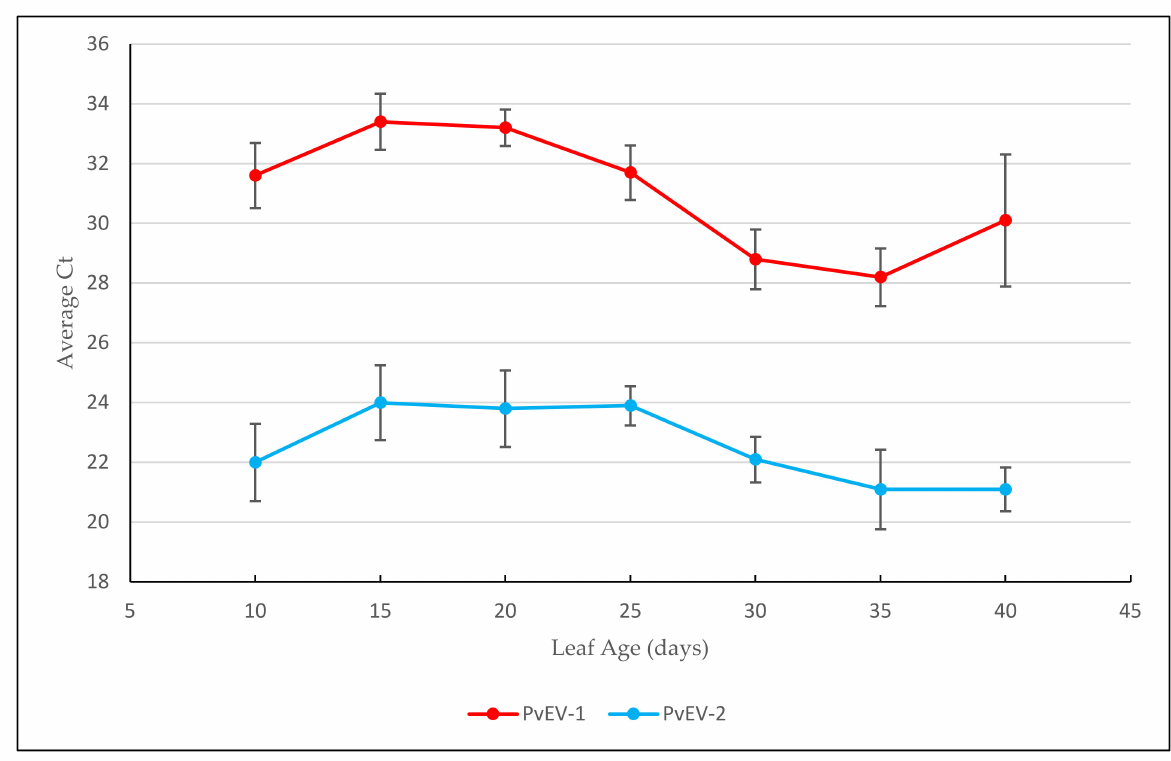
Figure 1. Average Ct values of endornaviruses PvEV-1, PvEV-2 from extracted TNA of common bean leaves over a 40-day developmental period. The bars indicate standard